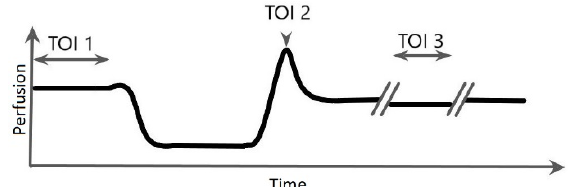
Figure 2. Placements of Timespans of Interest (TOI) of Laser Speckle Contrast Imaging scans. TOI 1: baseline, TOI 2: Post-Occlusive Reactive Hyperaemia test, peak perfusion after reperfusion. TOI 3: Buerger’s test. //: Short break in scan to reposition the foot before and after the Buerger’s test.